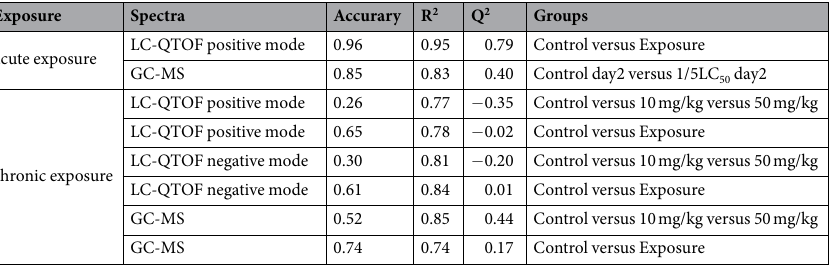
Table 2. Cross validation results of partial least squares discriminant analysis model from LC-QTOF and GC-MS spectra after acute and chronic exposure using two